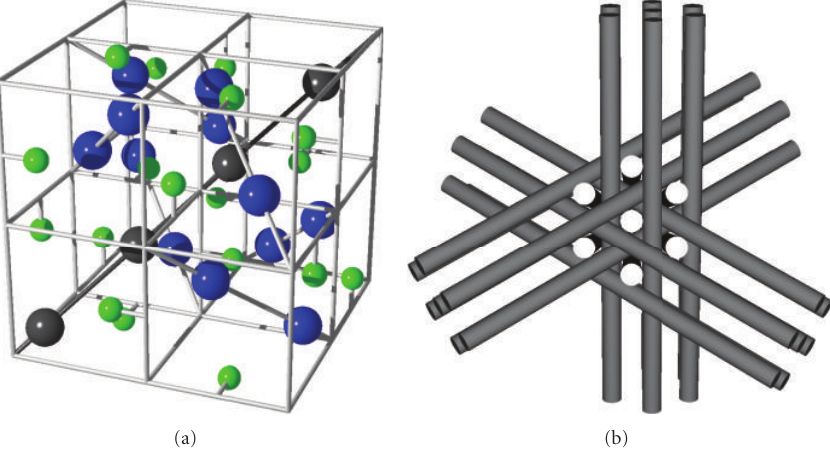
Figure 75: (a) Structure of Yb 4 X 3 . Large balls: Yb ions, small balls: pnictide ions. In the trigonal charge-ordered phase the black large balls indicate Yb 2+ sites and the gray large balls Yb 3+ sites. (b) The four families of chains formed by the Yb atoms.